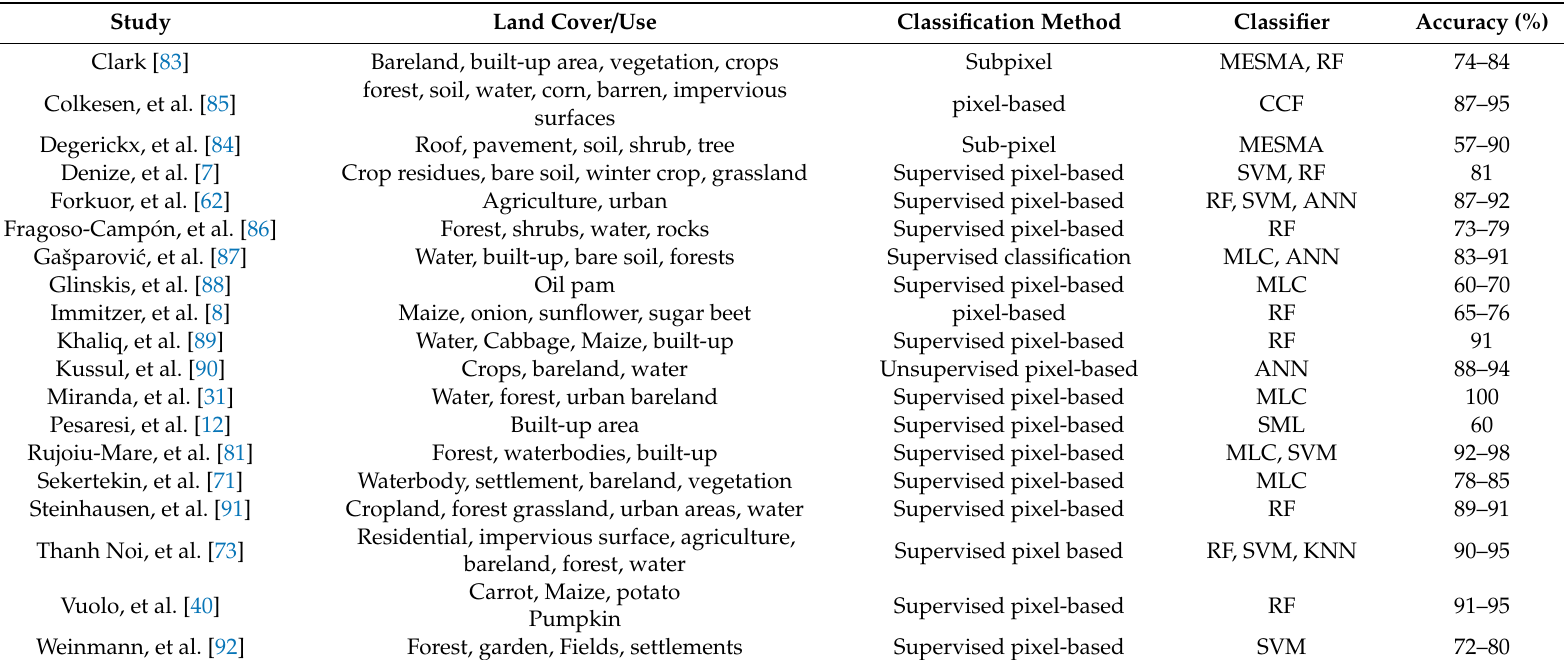
Table 3. Selected studies on pixel and sub-pixel-based land cover / use classification of Sentinel-2